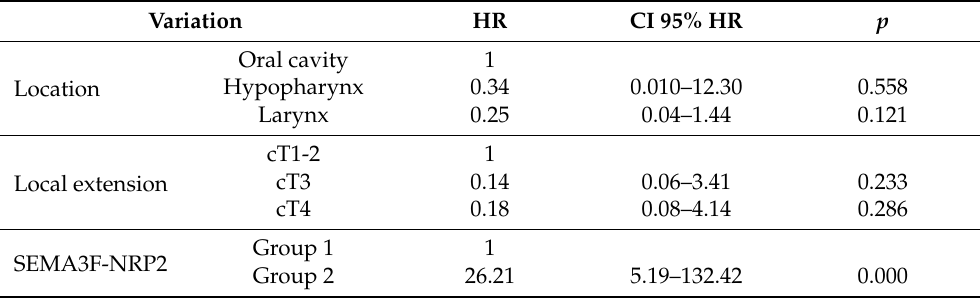
Figure 1. ( A ): Classification tree according to the transcriptional expression values of SEMA3F and NRP2 considering the presence of occult lymph node metastases as the dependent variable. ( B ): Heatmap of SEMA3F and NRP2 according to the results obtained in the classification tree. Table 2. Results of a multivariate analysis considering the appearance of occult lymph node metas- tases as the dependent variable (HR: hazard ratio).